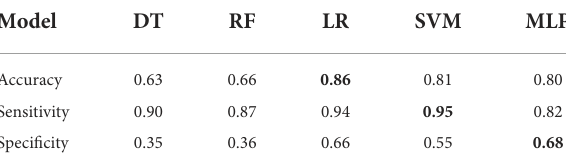
TABLE 5 Best ML model results for the applied metrics and the full data